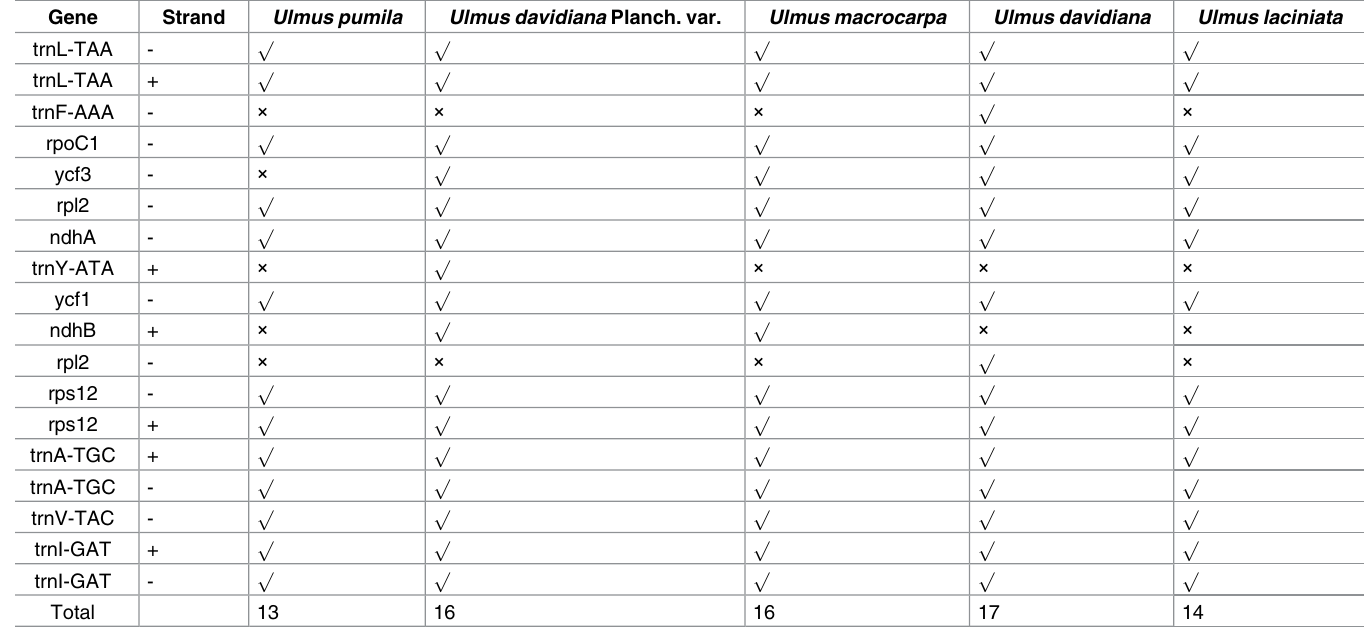
Table 2. Statistics of gene introns in the chloroplast genome of five Ulmus species. Gene Strand